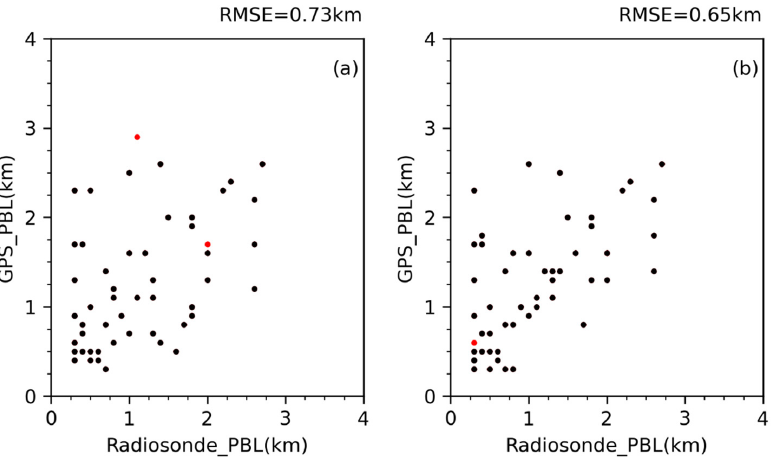
Figure 6. Scatter plots of the PBLHs over the ocean determined using COSMIC RO ( a ) N and ( b ) N i data with radiosonde potential temperature data during 2007–2011. The red dots indicate the excluded points with LSW >